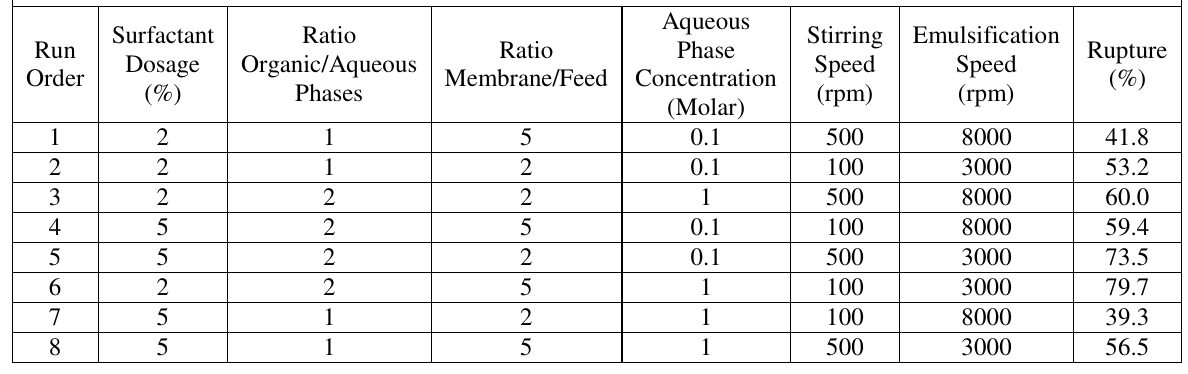
TABLE 2. EXPERIMENTAL ARRAY WITH EXPERIMENTALLY OBTAINED